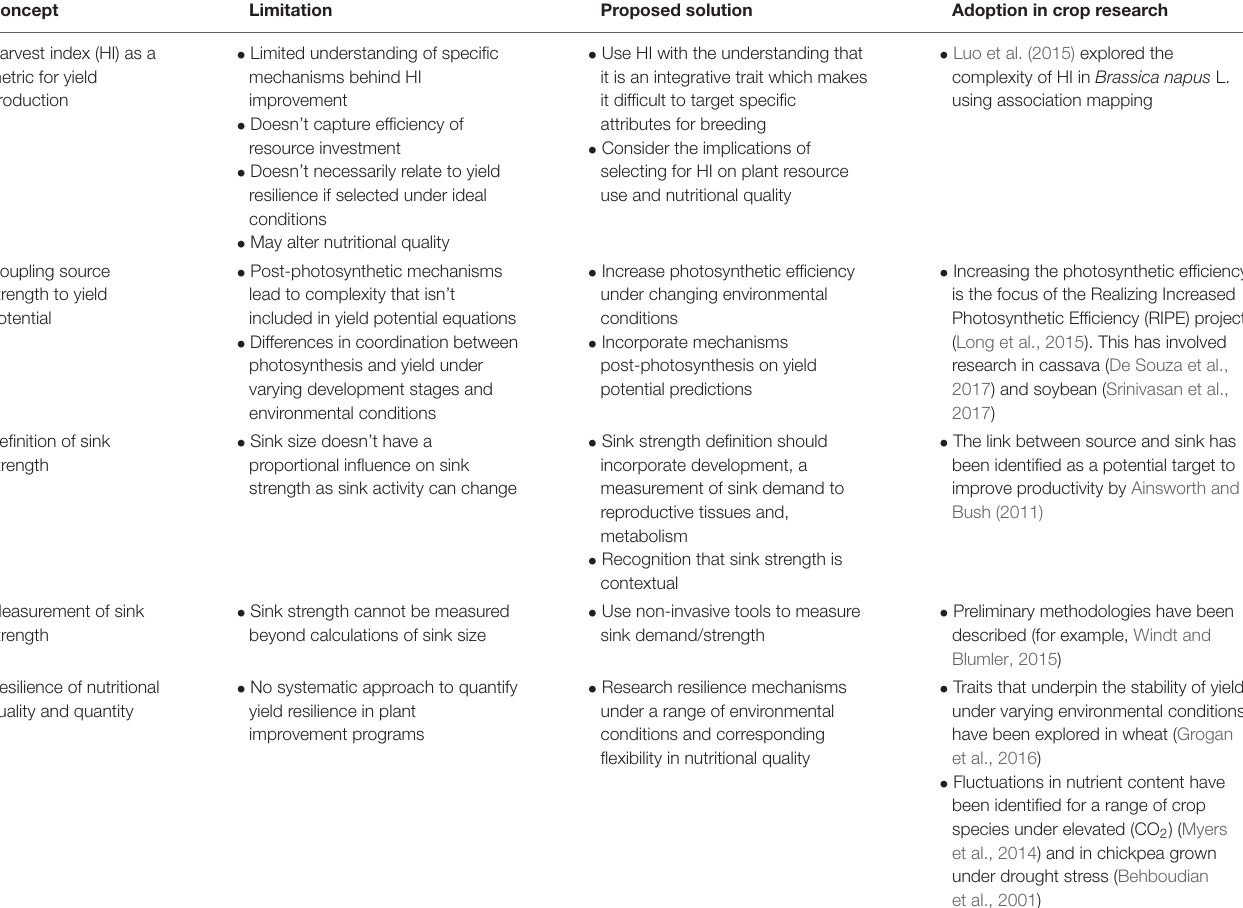
( Figure 2 ). Measurement of nutritional quality and yield quantity under a range of environmental conditions may be used as a framework for phenotyping a given agricultural